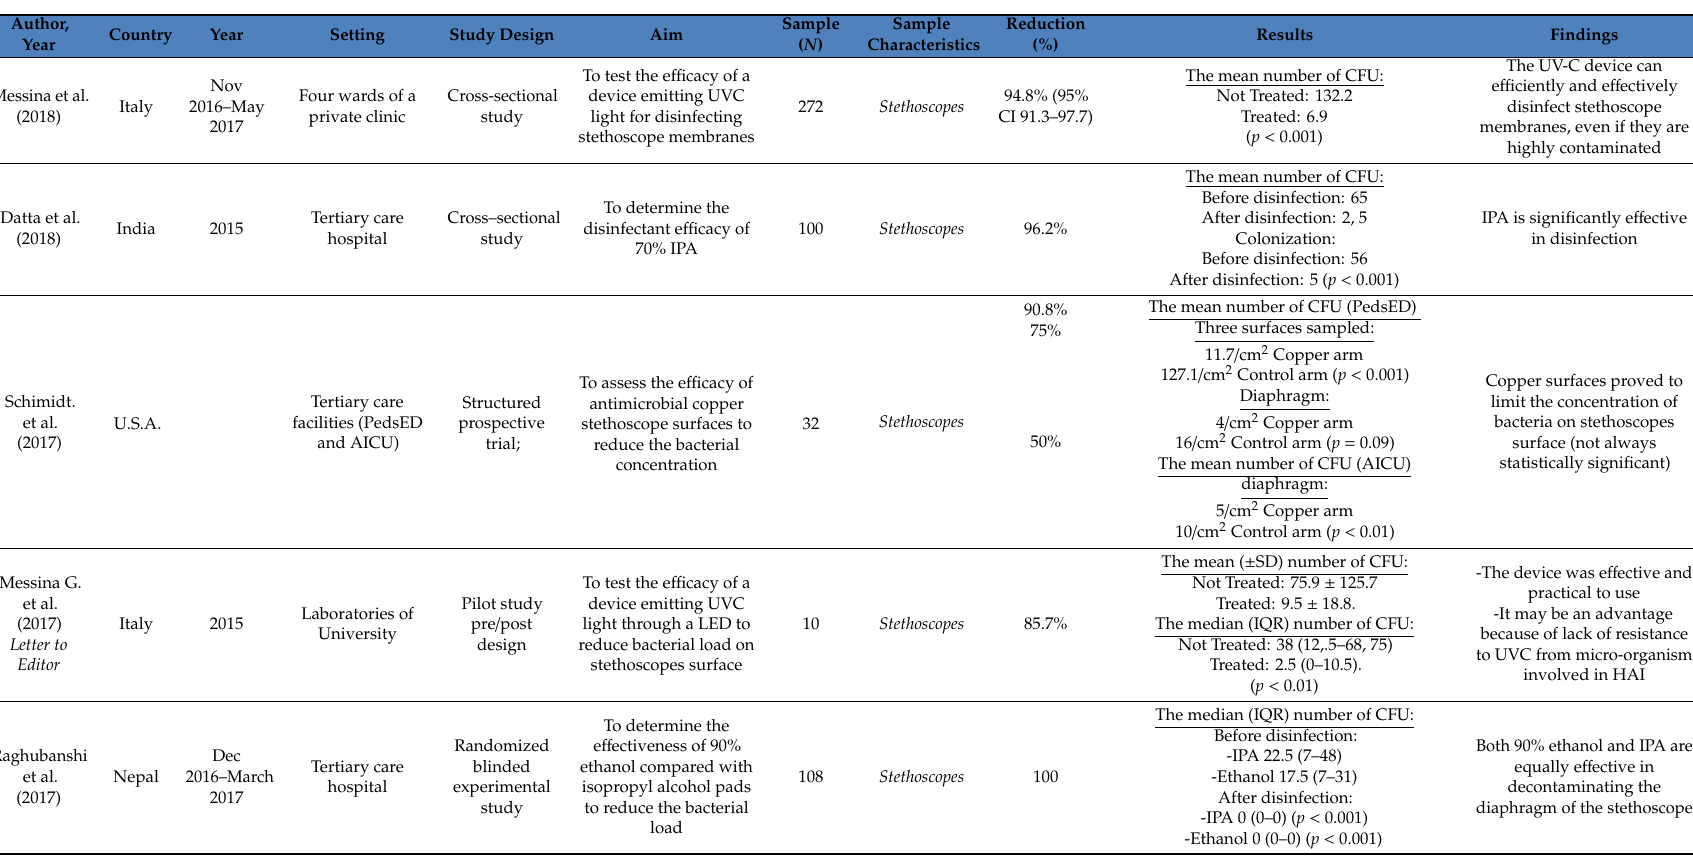
Table 1. Main characteristics of the studies included in the systematic